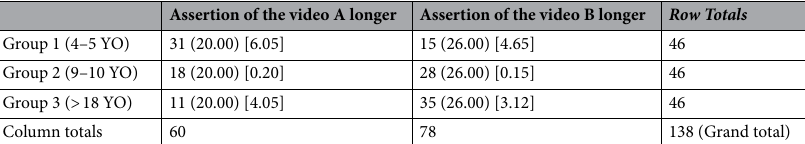
Table 1. The contingency table for the Chi-square test on the perceived duration of movie clips. Integer numbers represent the observed cell totals, numbers inside parentheses are the expected cell totals, and numbers in square brackets are the Chi-square statistic for each cell. Marginal distributions are indicated under Row Totals and Column Totals.